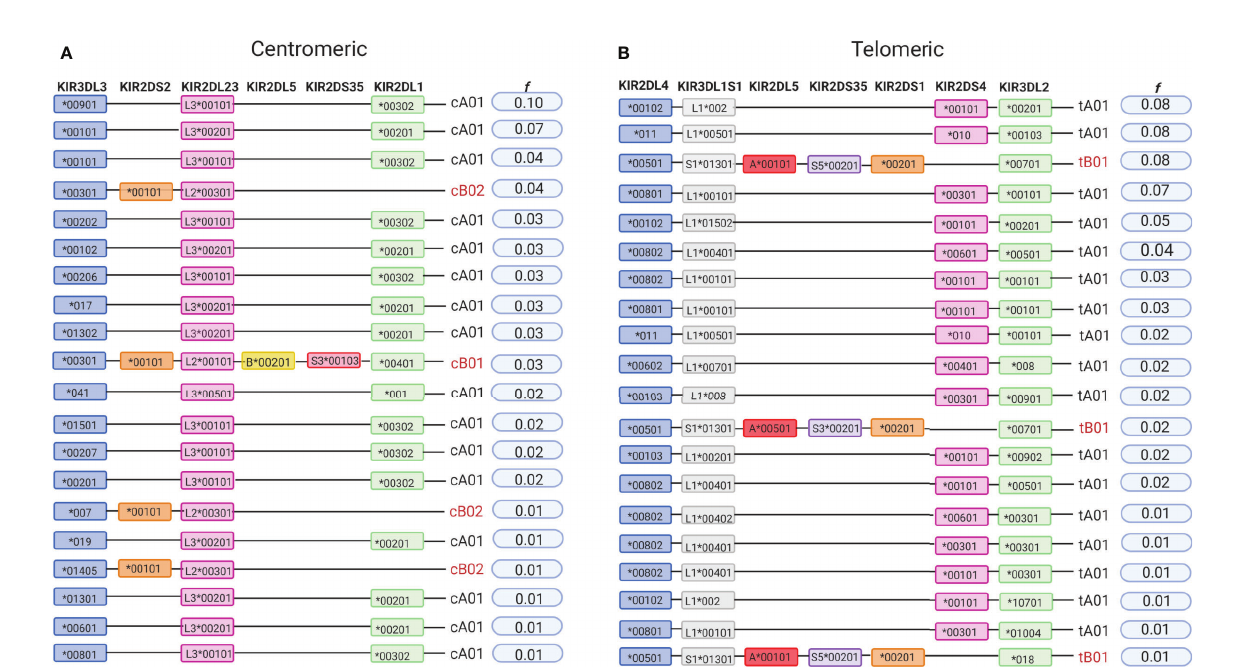
FIGURE 5 | High-resolution allelic haplotypes in European-Americans. (A) The 20 most common centromeric KIR haplotypes. (B) The 20 most common telomeric KIR haplotypes observed in European Americans (n = 2,130). Created with